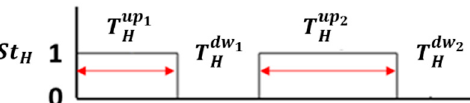
Figure 5. Chronological State Model of Hydropower Plant.